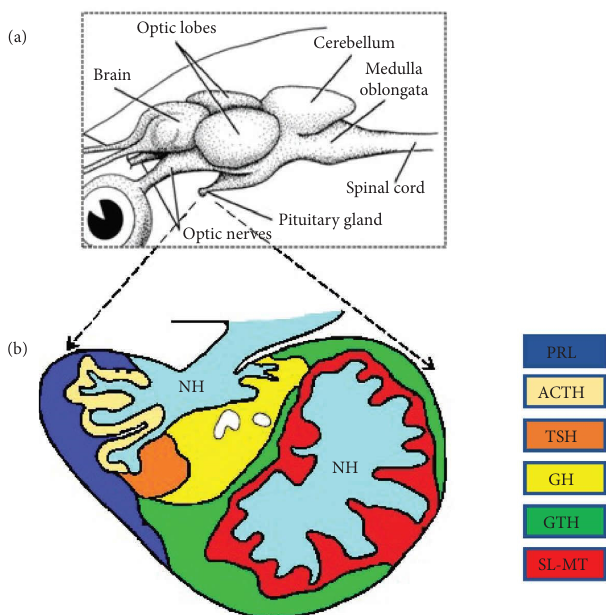
Figure 1: Anatomy and histology of fsh pituitary. Schematic representation of fsh brain showing the anatomical localization of the pituitary gland (a) and the distribution of adenohypophyseal cells in Diplodus sargus (b). NH, neurohypophysis (light blue). PRL, lactotropes (blue). ACTH, corticotropes (ivory white). GH, somatotropes (yellow). GTH, gonadotropes (green). TSH, thyro- tropes, (orange). SL+MSH, somatolactotropes and melanotropes (red). Modifed drawing from the study of Segura-Noguera et al. [30] (b) and from Living Ocean, CRDG, University of Hawaii at Manoa